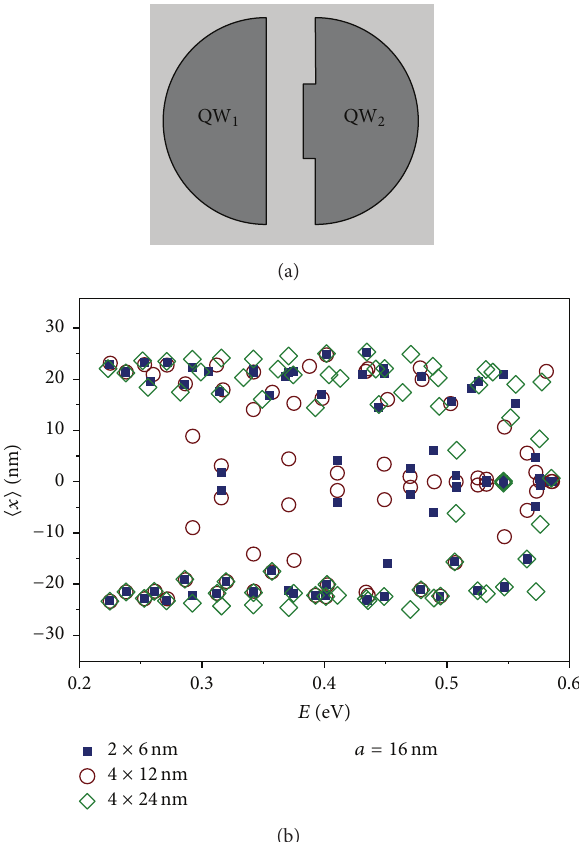
Figure 12: (a) Semicircle shaped DQW, where the asymmetry is generated by a rectangular defect in the right QW. The defect height, 𝐻 ,andwidth, 𝐷 ,werevaried,asindicatedintheinset,whiletheradii and the dot interdistance are maintained constant ( 𝑅 1 = 𝑅 2 = 40 nm and 𝑎 = 16 nm).(b)Electronaverageposition ⟨𝑥⟩ plottedagainstthe electron spectrum of the asymmetric